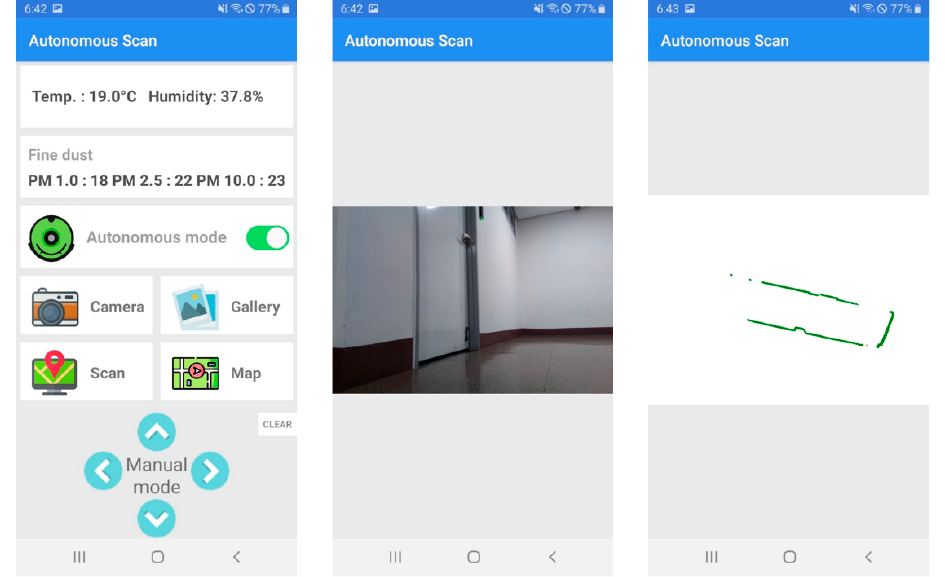
Figure 26. Indoor space at position (marked 6 in Figure 23) from which second autonomous scanning experiment was performed.